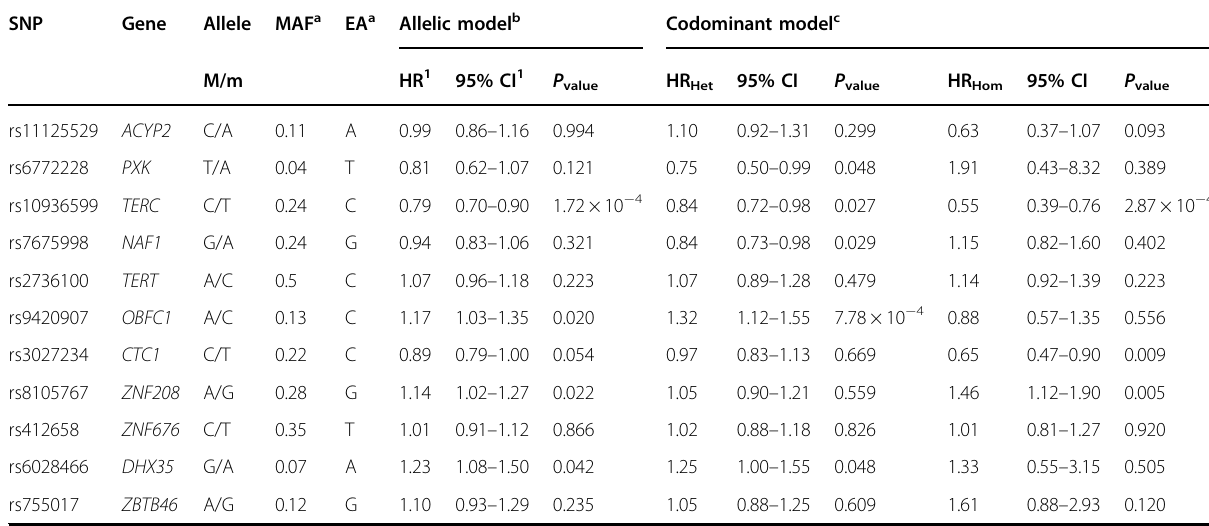
Table 2 Association between single SNPs and MM